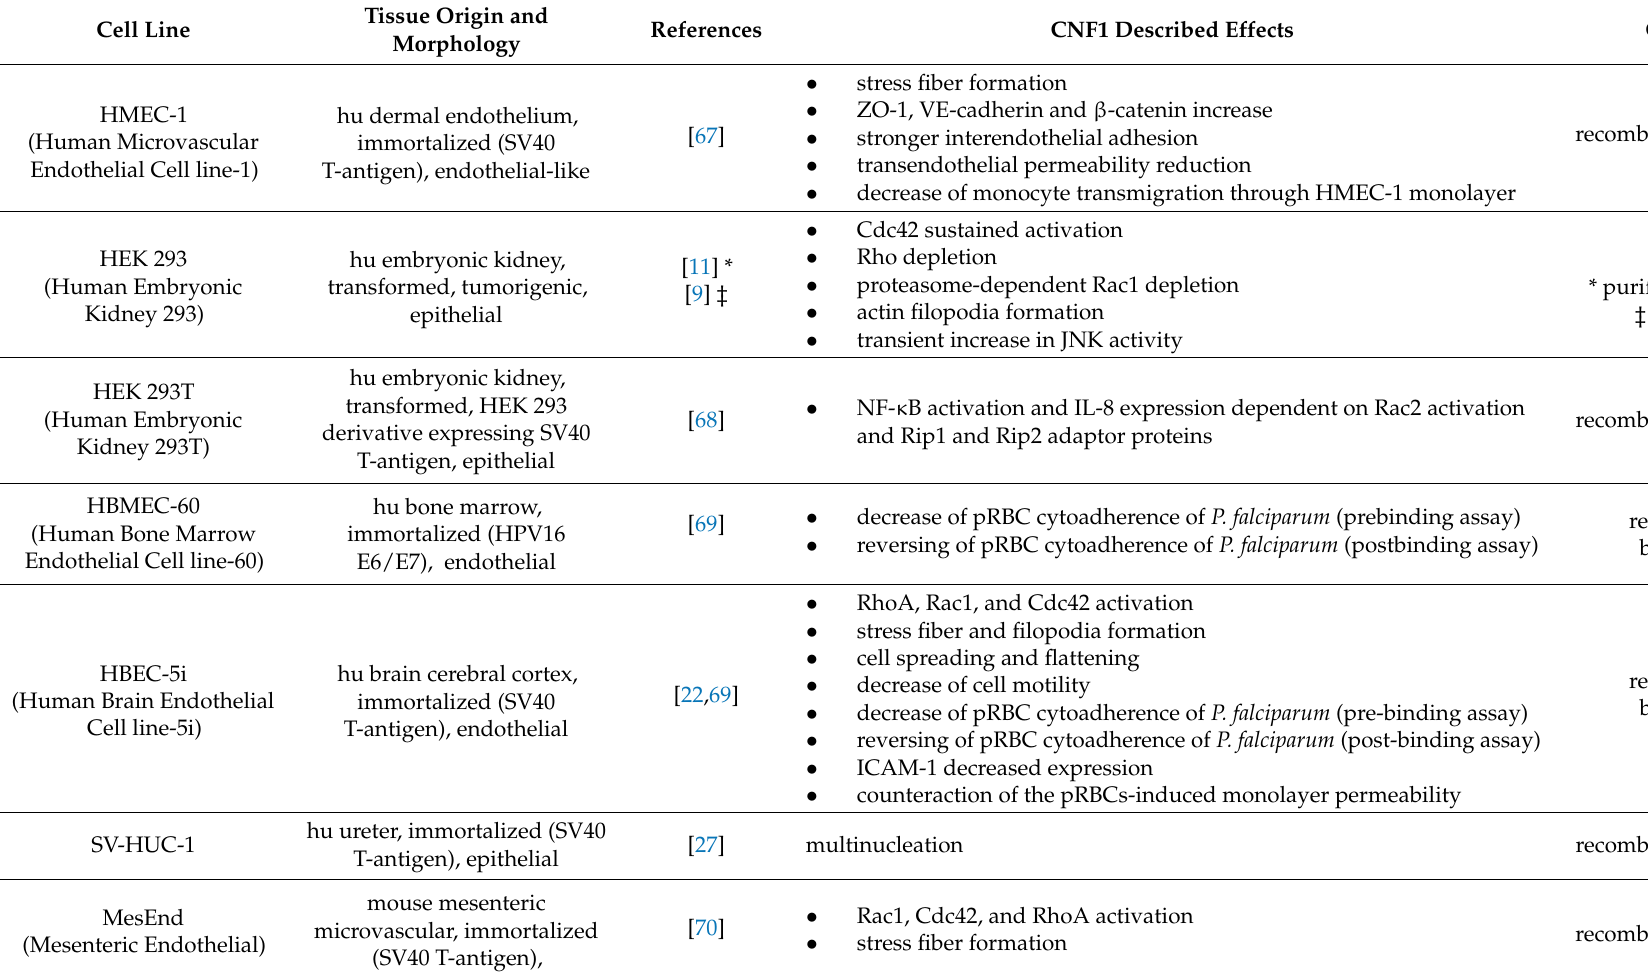
Table 2. Immortalized/transformed cell